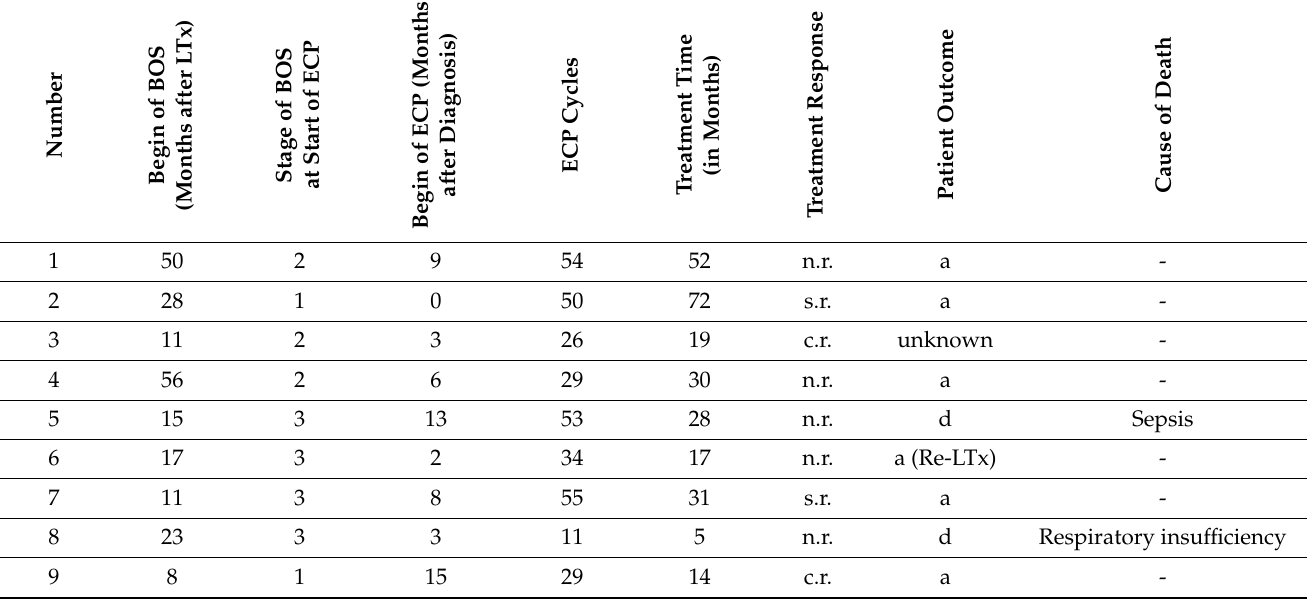
Table 5. BOS-patient response to ECP and outcome (n.r. = not response, c.r. = clinically objectifiable response but not statistically significant, s.r. = significant response, a = alive, d = dead, Re-LTx = Lung-